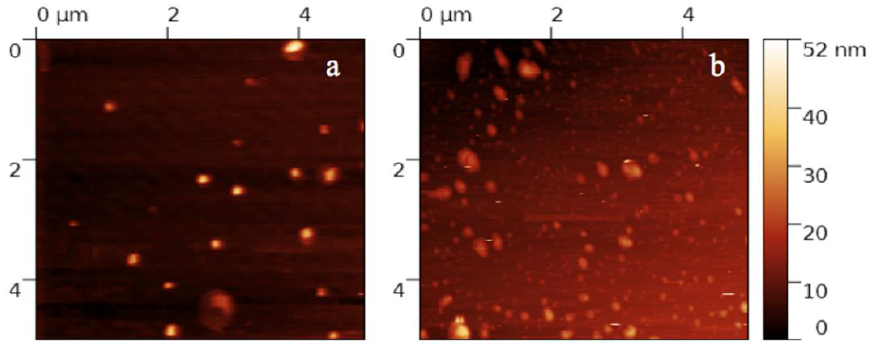
Figure 2. AFM topographic image 5 × 5 µm of U-SLNs ( a ) and PEA-SLNs ( b